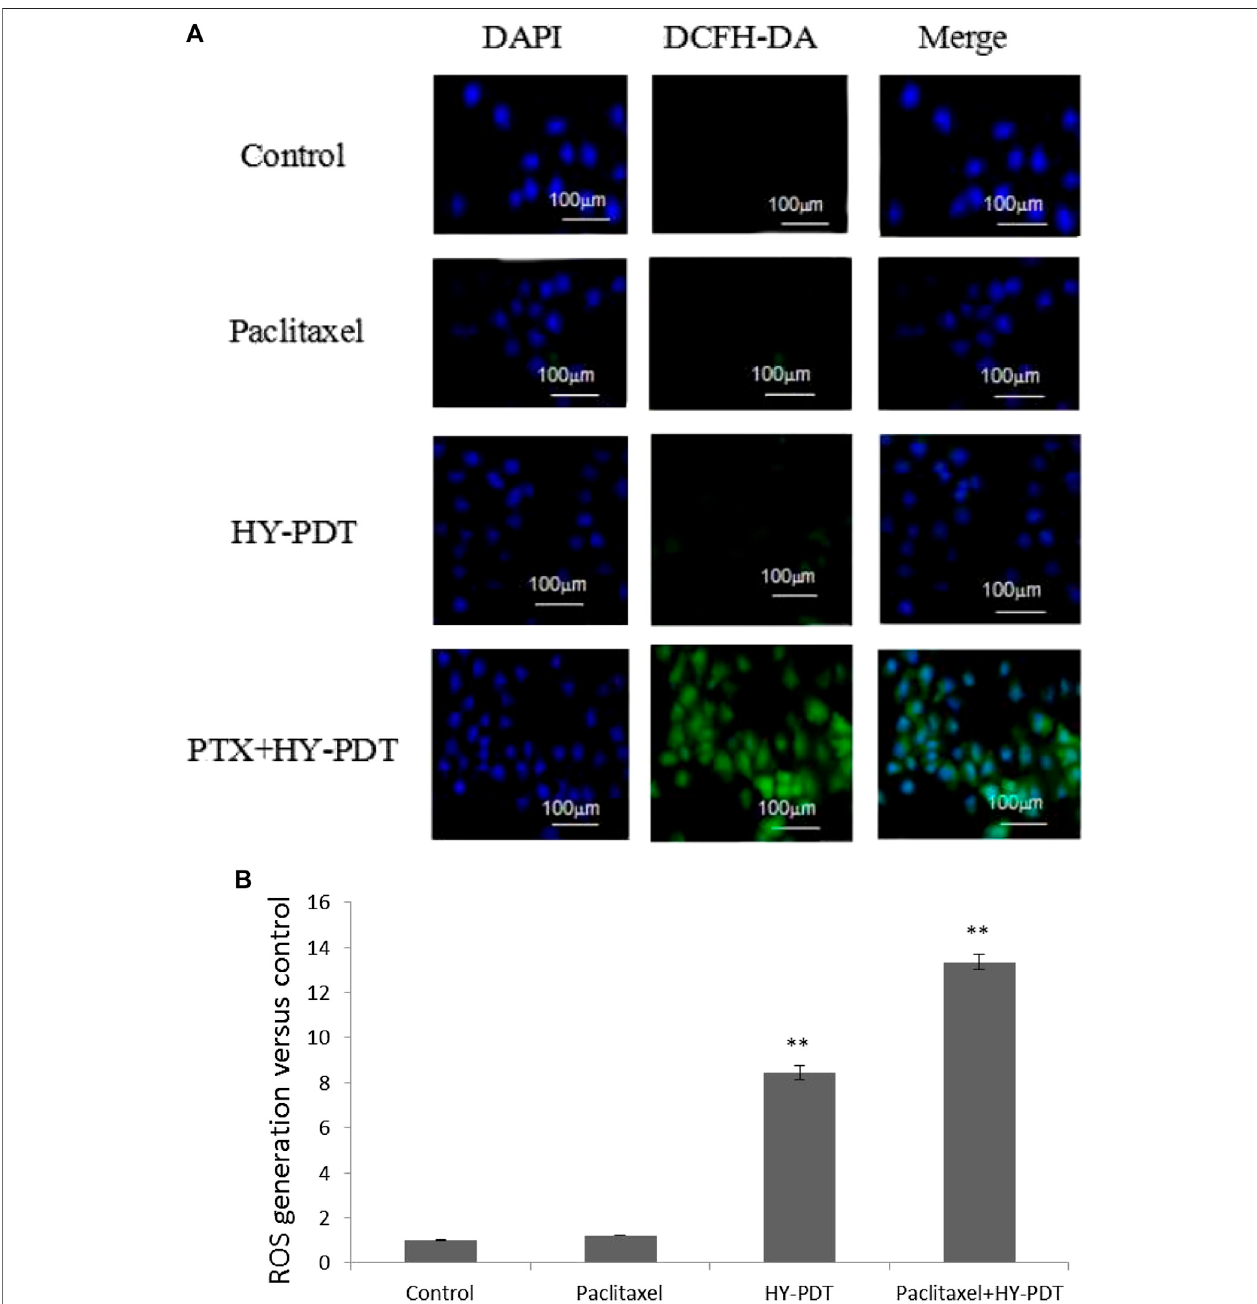
FIGURE6| ROSlevel analysisofB16-F10cells by fl uorescenceintensityafter drugtreatment. (A) B16-F10cellsweretreatedwith thepaclitaxel (1 μ g/ml)and HY- PDT(1 μ g/ml)aloneorincombination(0.5 μ g/mleach).GenerationofROSwasobservedundera fl uorescencemicroscope.Scalebars:100 μ m. (B) ImageJprocessing calculation to obtain relative fl uorescence intensity. ** p < 0.01, compared to control.